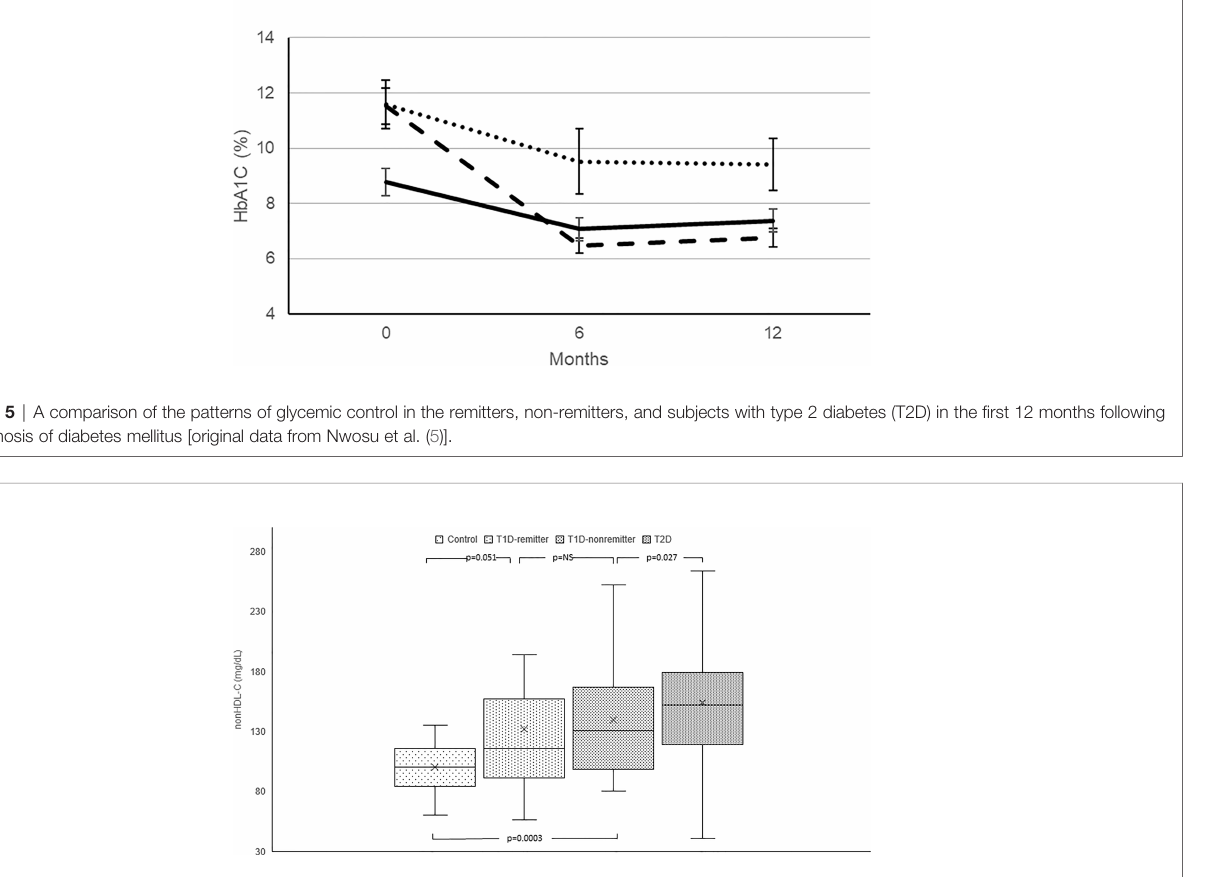
FIGURE 6 | Box plots of early post-diagnostic patterns of non-high density lipoprotein cholesterol (non-HDL-C) in the remitters, non-remitters, and subjects with type 2 diabetes (T2D) compared to controls. The box represents the 50th percent interquartile range, while the ‘ x ’ represents the mean and the horizontal line within the box represents the median, and the upper and lower whiskers represent 25 th percentile above and below the mean, respectively